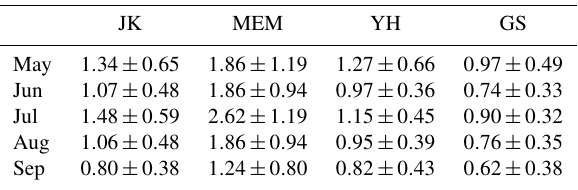
Table 2. Wind speed (ms − 1 ) measured about 10m above ground level at every site during the sampling